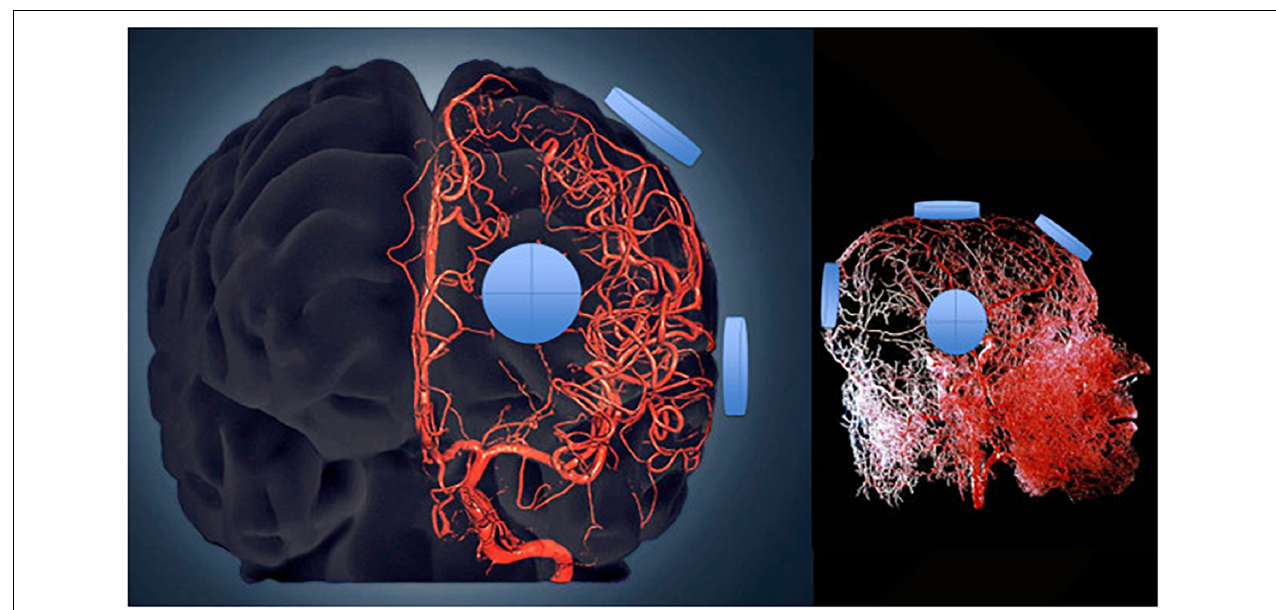
FIGURE 8 | Three-dimensional model of the cerebral arterial tree showing the location of four emitters on the surface of the head’s right side for the MemorEM device. The emitters (blue disks) are in close proximity to affect all blood components within the cerebrovascular tree including arteries/arterioles and most importantly capillaries, where the velocity of blood cells and plasma is at its slowest for maximal EMF